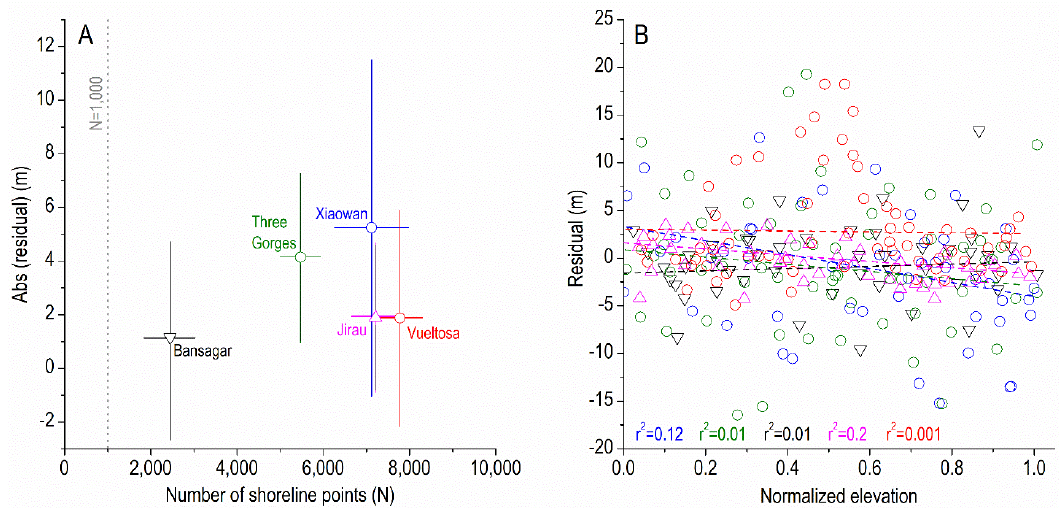
Figure 5. ( A ) Absolute value of residuals plotted against the number of shoreline points. Mean (symbol) and standard deviation (whisker) are shown. ( B ) Residuals of SAR–driven WL calculated from the altimetry series for each reservoir. WL estimates after the reservoir filling were considered.